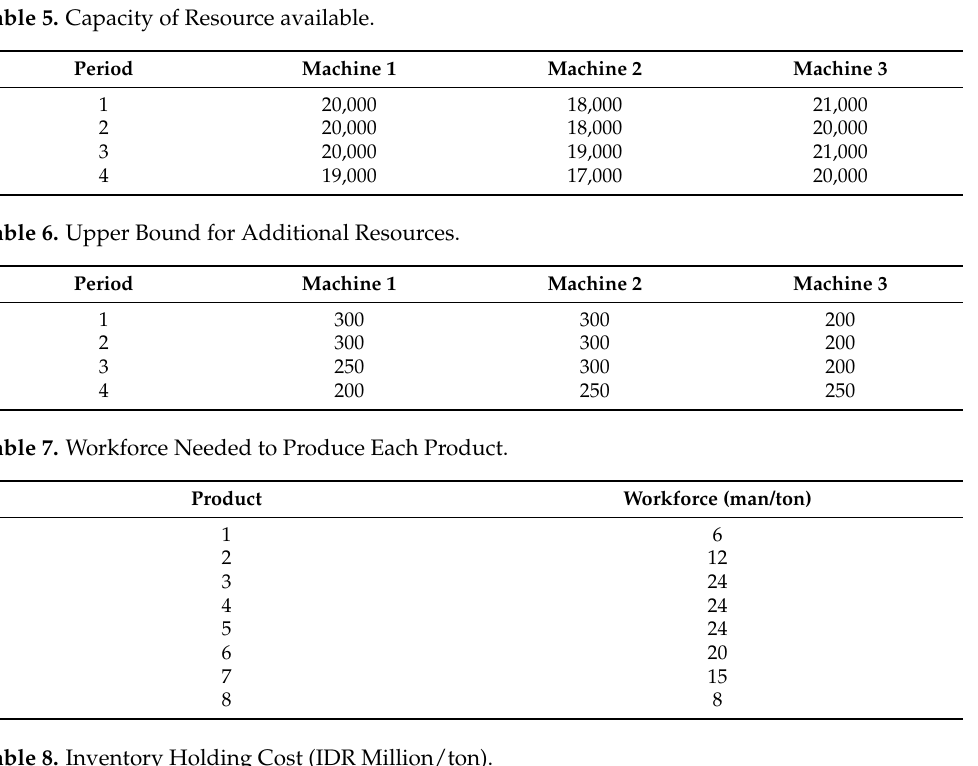
Table 8. Inventory Holding Cost (IDR Million/ton).